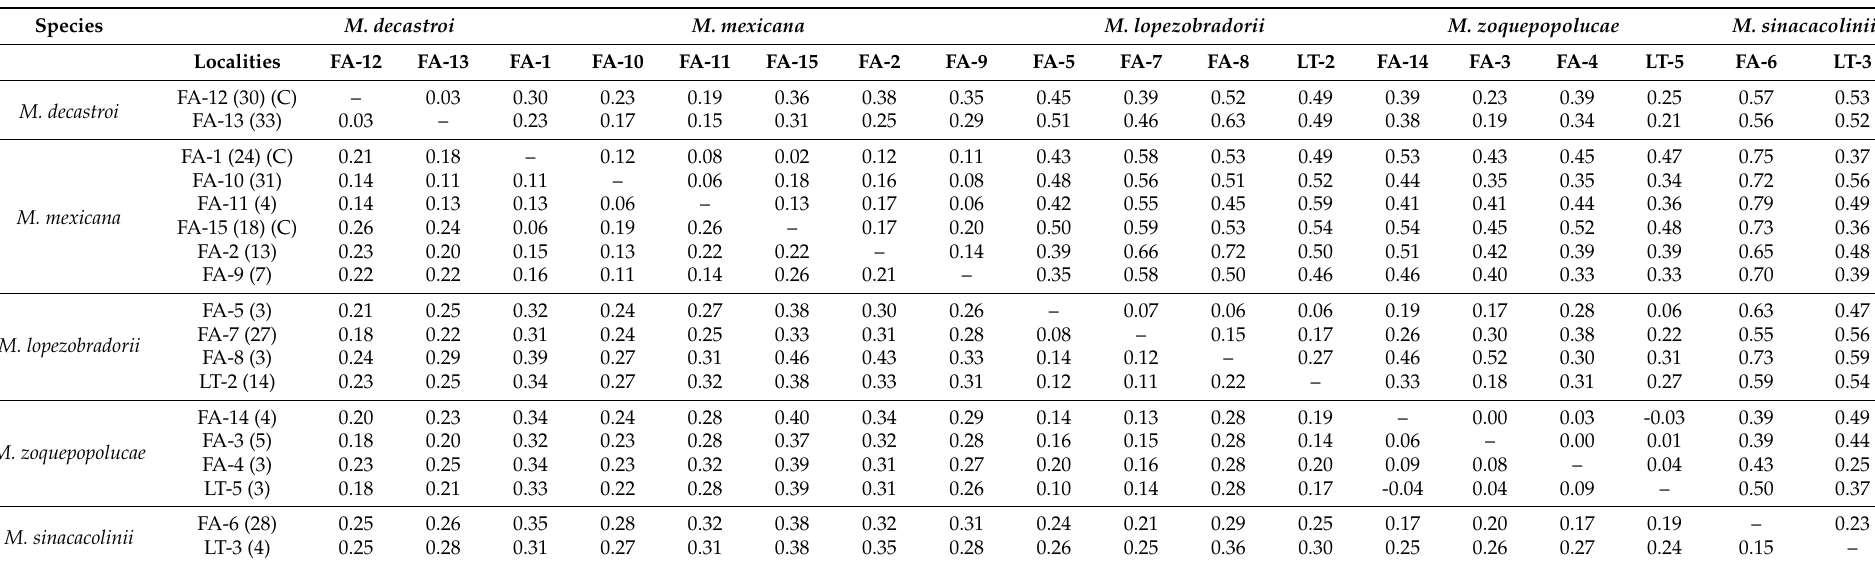
Table 2. Pairwise F ST and D JOST values between the 18 localities of Magnolia species in Puebla and Veracruz, Mexico. Above the diagonal pairwise D JOST values are tabulated. Below the diagonal pairwise F ST values are tabulated. Locality metadata can be found in Table 5. In blue the intraspecific values. (C) marks cultivated sampling localities as opposed to wild sampling localities.